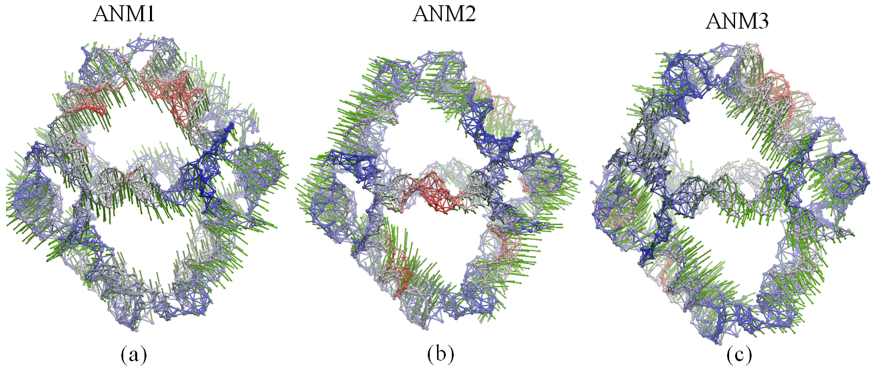
Figure 5. Global motions predicted by: ( a ) ANM1; ( b ) ANM2 and ( c ) ANM3. Red and blue colors denote regions with high and low fluctuations, respectively, while arrows (green) denote the direction of the motions.